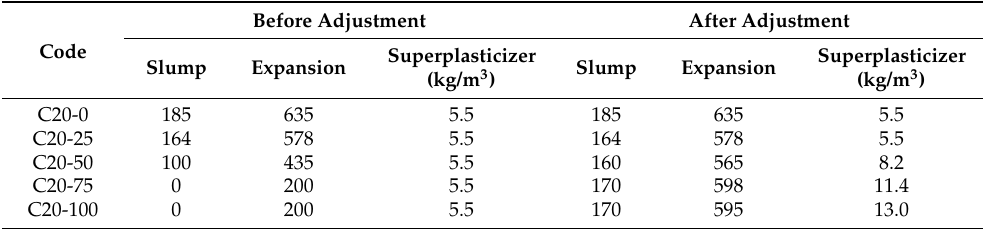
Table 6. Workability of C20 fresh concrete (mm).